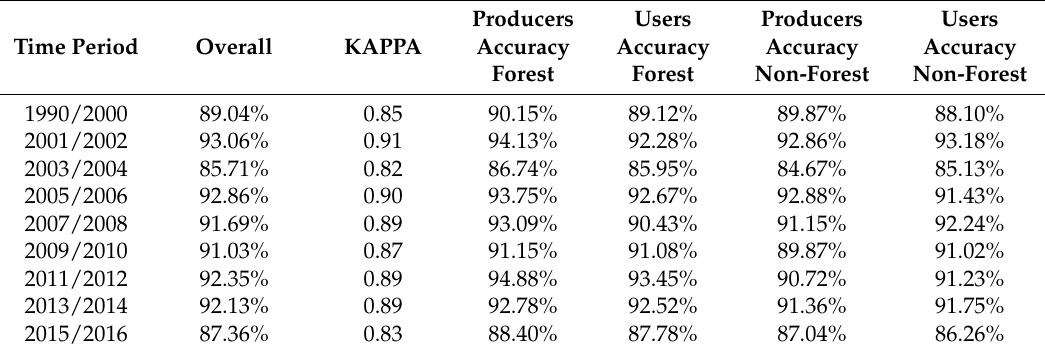
Table 2. Classification accuracies for each time step from 1999 to